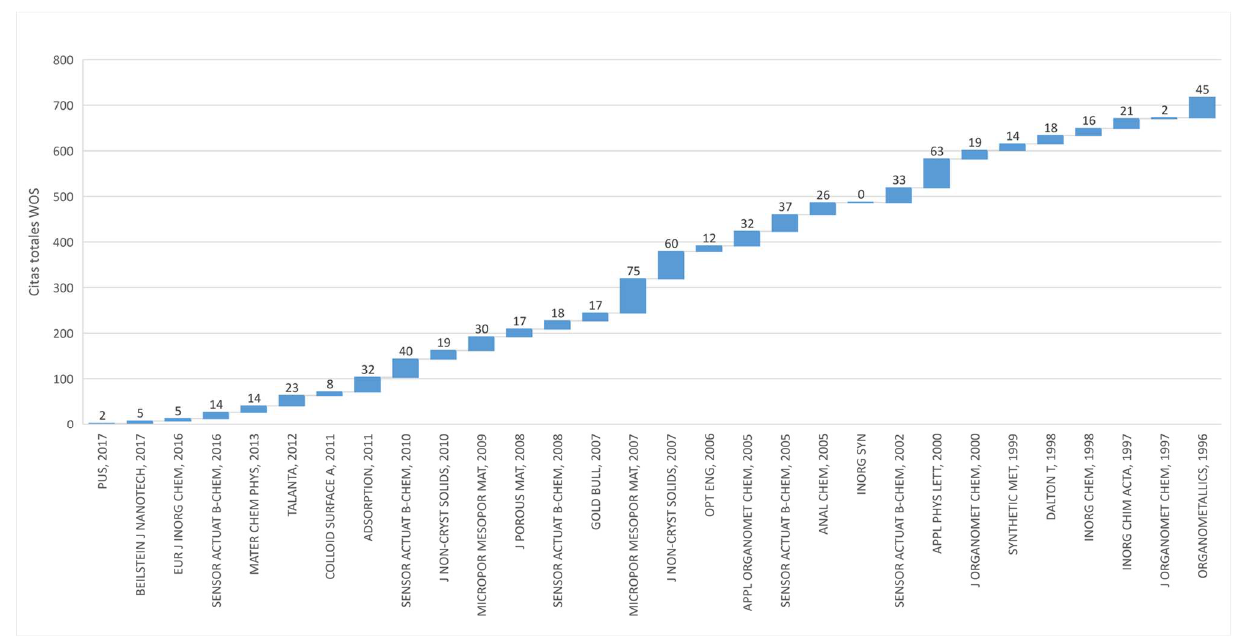
Figure 5. Cumulative frequency of total citations of each of the 36 publications from the line of re- search on sensors in the IC Group (UPNA). Data taken from the WOS (2 October 2021). From 1996 to 2020, a total of 36 papers with 194 bylines were published in this line of research (Figure 5). The number of bylines differs from the number of authors, as several male and female authors contributed to more than one paper. Of the bylines, 132 corre- spond to men (68.0%), and 62 correspond to women (31.9%); see Table 2. The calculation of the number of bylines per author also reflects this difference (31 male authors versus 23 female authors). Consequently, the average number of bylines by female authors is also lower.